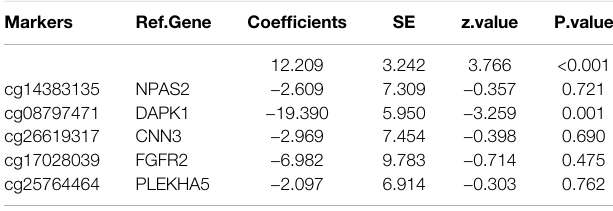
TABLE 2 | Characteristics of fi ve methylation markers and their coef fi cients in GC diagnosis. Markers Ref.Gene Coef fi cients SE z.value